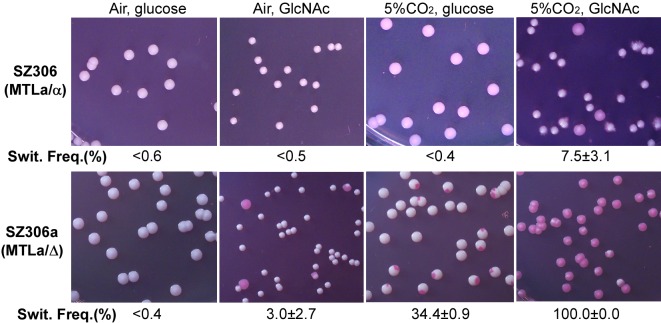

MTLa/Δ derivatives are more sensitive to GlcNAc and CO2 than natural a/α strains.White-to-opaque switching in SZ306 (a/α) and SZ306a (a/Δ) were tested under four conditions indicated. Lee's glucose or GlcNAc medium was used for cell growth. Homogeneous white cells from Lee's glucose plates were plated. The total colony number examined for each strain was 350 to 500. Switching frequencies (% of average ± standard deviation, SD) are shown below the images. “<” indicated no opaque or opaque-sectored colonies were observed.